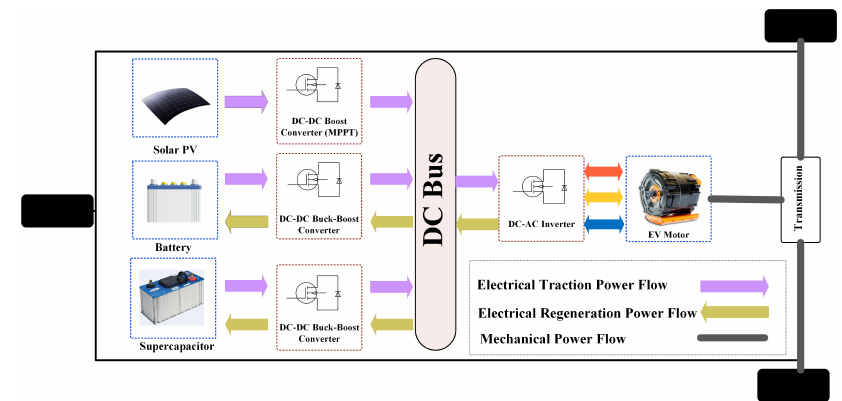
Figure 1. Power train of hybrid source system in electric 3W